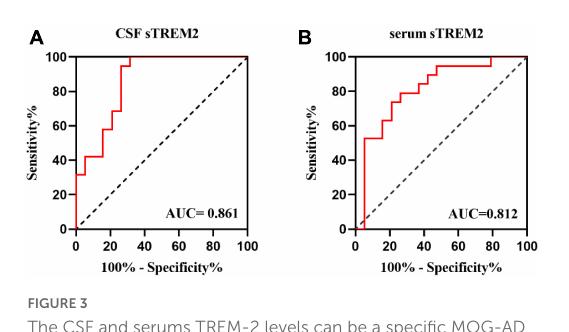
FIGURE3 The CSF and serums TREM-2 levels can be a specific MOG-AD diagnosis biomarker. (A,B) Receiver operating characteristic (ROC) curve analysis of sTREM2 in CSF and serum for MOG-AD diagnosis ( N = 38). (A) The area under the curve (AUC) of CSF sTREM2 levels was 0.861 ( p < 0.001). (B) The area under the curve (AUC) of serum sTREM2 levels was 0.812 ( p =